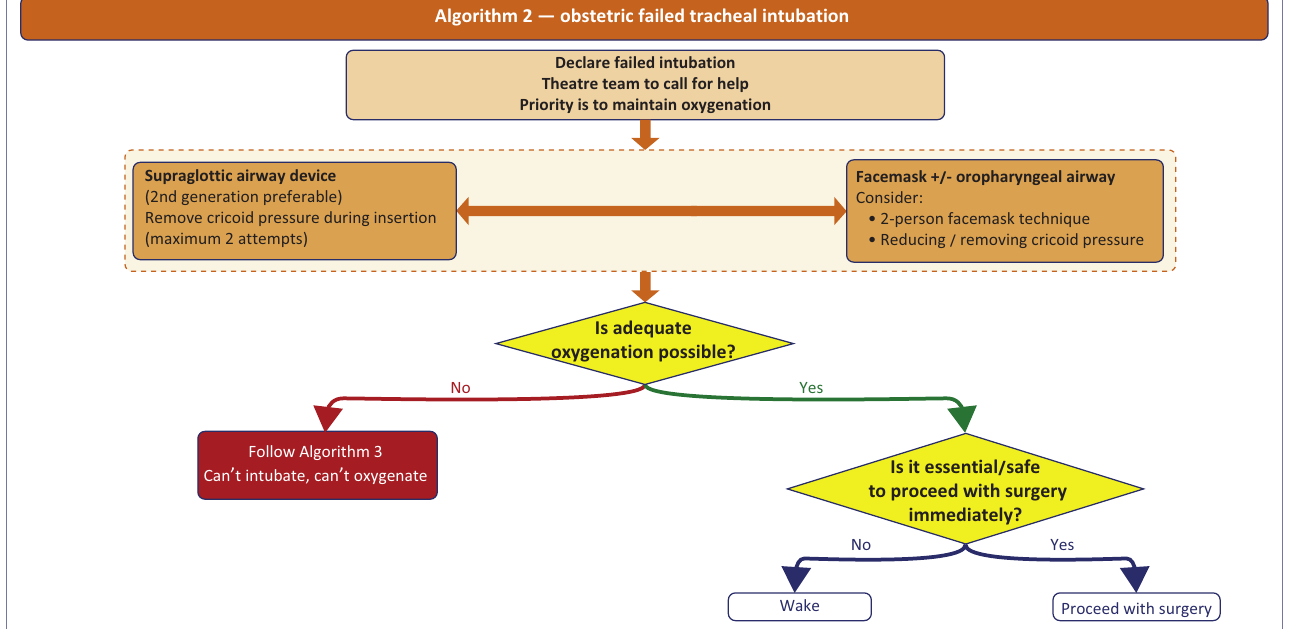
Algorithm 2 — obstetric failed tracheal